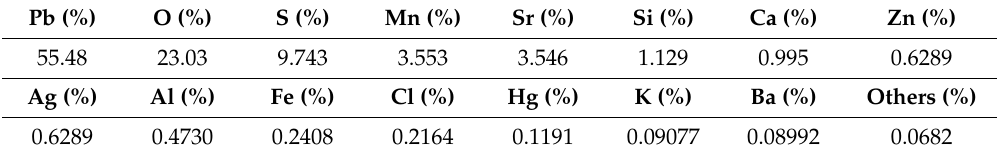
Table 2. Compositions of the filtration by-product (mass %). Determined by X-ray fluorescence. Pb (%) O (%) S (%) Mn (%) Sr (%) Si (%) Al (%) Fe